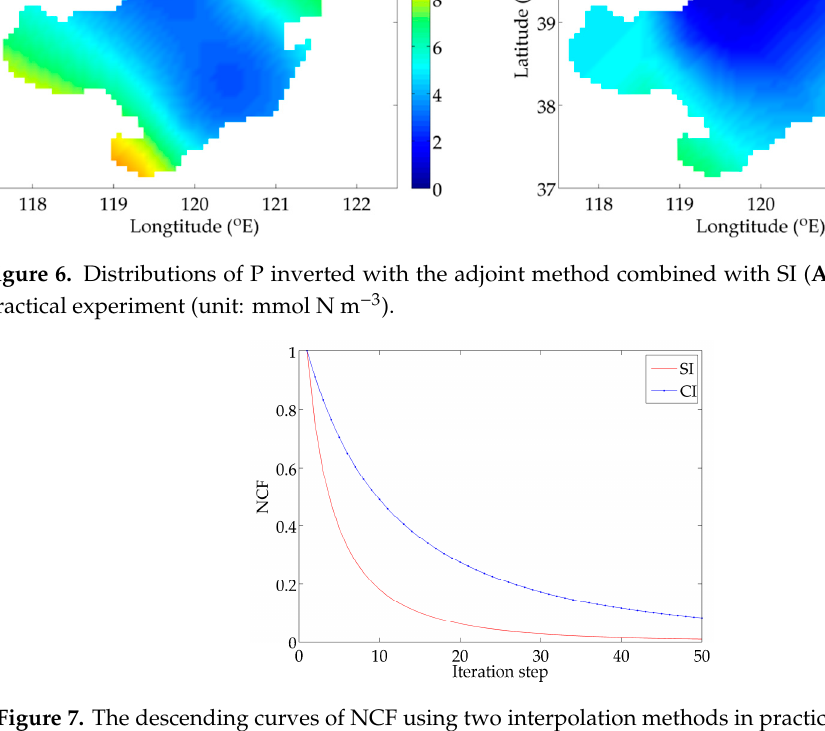
Figure 7. The descending curves of NCF using two interpolation methods in practical experiment.